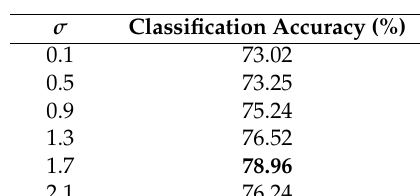
Table 2. Average classification accuracy of the SIFT over neuroblastic tumour dataset using different values for σ . Bold value indicates the highest classification accuracy.